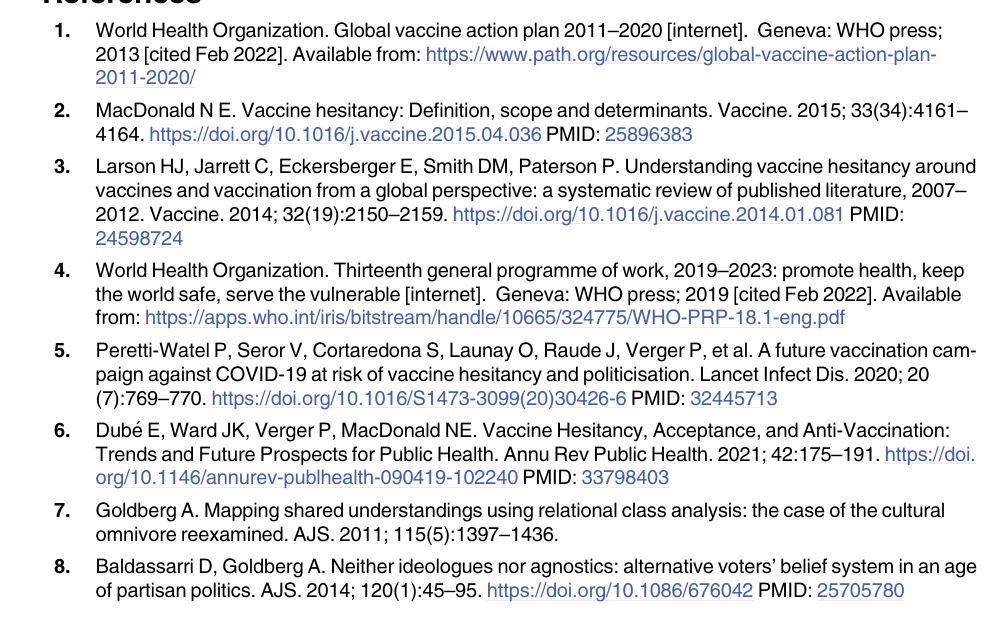
S6 Table. Binomial logistic regression models. Binomial logistic regression predicting the probability to be vaccine hesitant in each RCA group. Odds ratios. Weighted coefficients. S1 Fig. Exploratory factor analysis for each issue domain index. Each scale displays only a single factor with eigenvalue above 1. This result is robust to different factor analysis specifica-